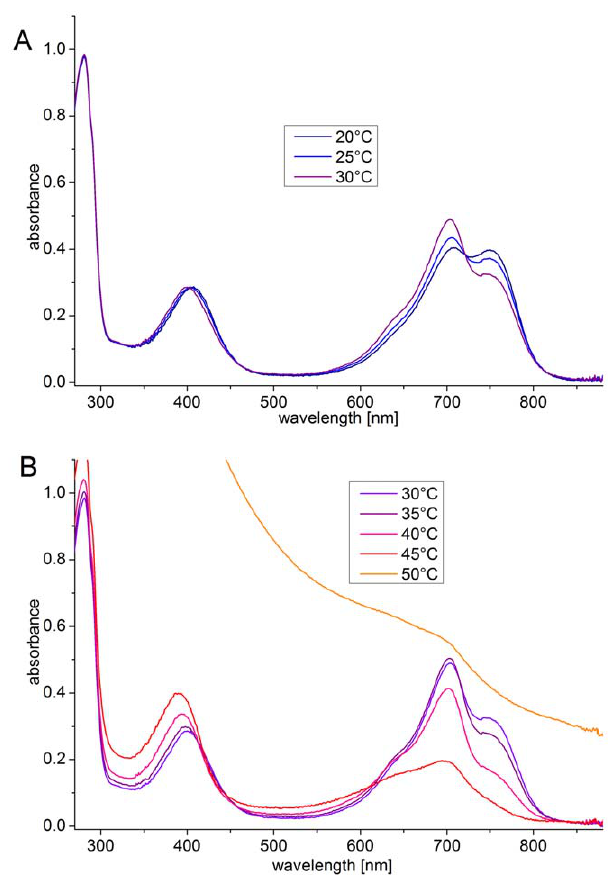
Figure 3. Absorption spectra of red-irradiated Agp1 at various temperatures. (A) Spectra in the 20 u C to 30 u C range. (B) Spectra in the 30 u C to 50 u C range. Before each scan, the sample was irradiated for 20 min with red light (655 nm; 20 m mol m 2 2 s 2 1 ).